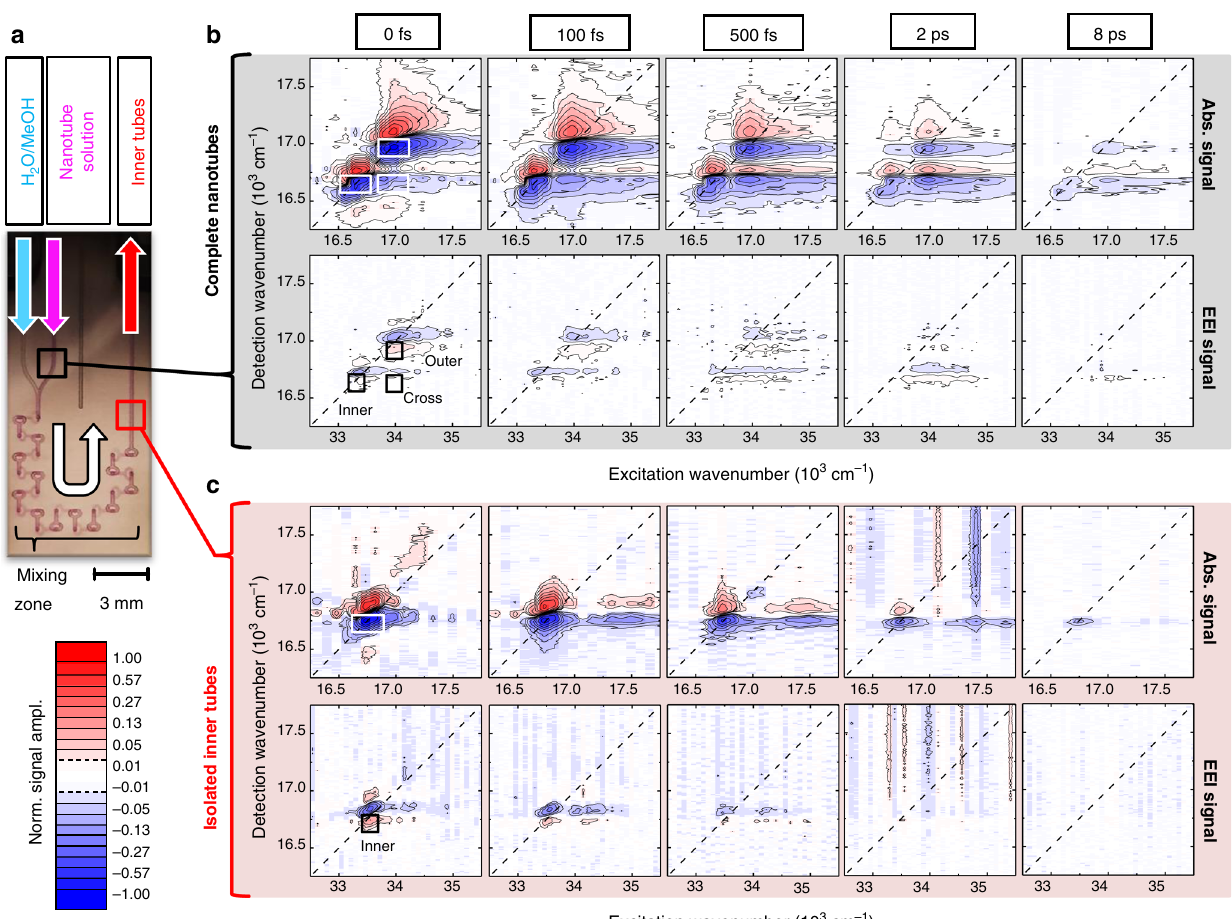
Fig. 2 Absorptive and EEI 2D spectra recorded before and after micro fl uidic fl ash-dilution. a A photograph of the cuvette for micro fl uidic fl ash-dilution via mixing of neat nanotube solution and a diluting agent (50:50 mixture by volume of H 2 O and methanol). Arrows indicate the fl ow direction of the solvents. ( b ) and ( c ) Representative absorptive 2D and EEI2D spectra at selected waiting times measured for complete (panel b; shaded gray) and isolated inner tubes (panel c; shaded red). The spectra were normalized to the maximum absolute amplitude at 0 fs waiting time. The signal amplitude is depicted on a color scale ranging from − 1 to 1, with increments at 0.83, 0.57, 0.4, 0.27. 0.19, 0.13, 0.08, 0.05, 0.03, and 0.01 to ensure visibility of all peaks at all waiting times. Contour lines are drawn as speci fi ed in the color bar except for the lower signal levels for isolated inner tubes. Negative and positive features in the absorptive 2D spectra refer to ground-state bleach/stimulated emission (GSB/SE) and excited-state absorption (ESA) signals, respectively. In the EEI2D spectra the signal signs are opposite, which is caused by the two additionally required interactions with the incident light fi elds and the associated factor of i 2 = − 1 within the perturbation expansion 28,43 . The direct comparability of the absorptive and EEI signals is ensured, because both signals are recorded under identical conditions, as they are emitted in the same phase-matched direction and captured simultaneously. Diagonal lines (dashed) are drawn at ω = ω ω = 2 ω excitation detection and excitation detection for absorptive 2D and EEI2D spectra, respectively. White and black rectangles depict the regions of interest in which the signal was integrated to obtain the transients (Supplementary Note 3 and Supplementary Table 1). The exciton density corresponds to one exciton per ~20 and ~60 individual molecules for isolated inner tubes and complete nanotubes, respectively. Additional 2D spectra for low exciton